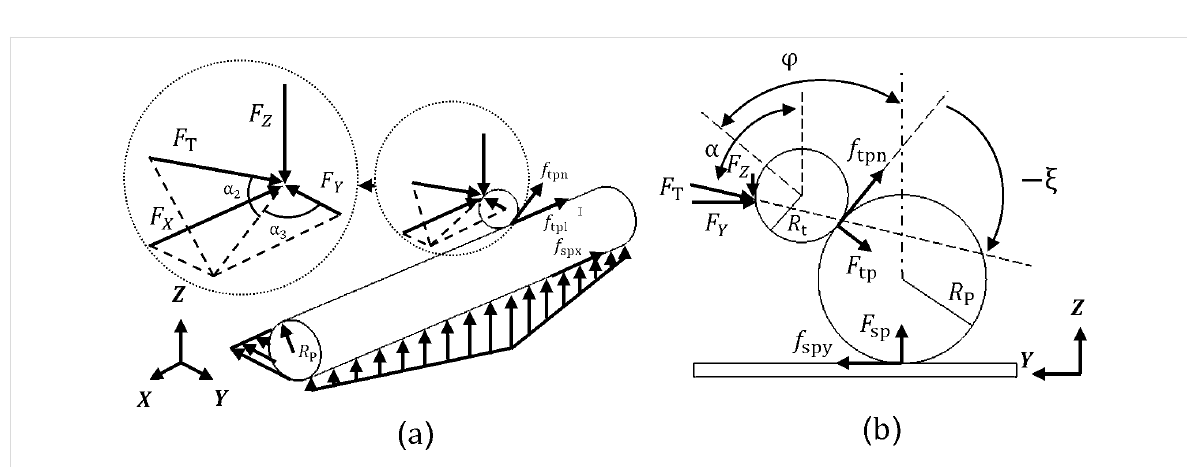
The required conditions to initiate the sliding and rolling modes of a cylindrical nanoparticle on the substrate in the lateral direc- tion in a 3D approach are, respectively, expressed by